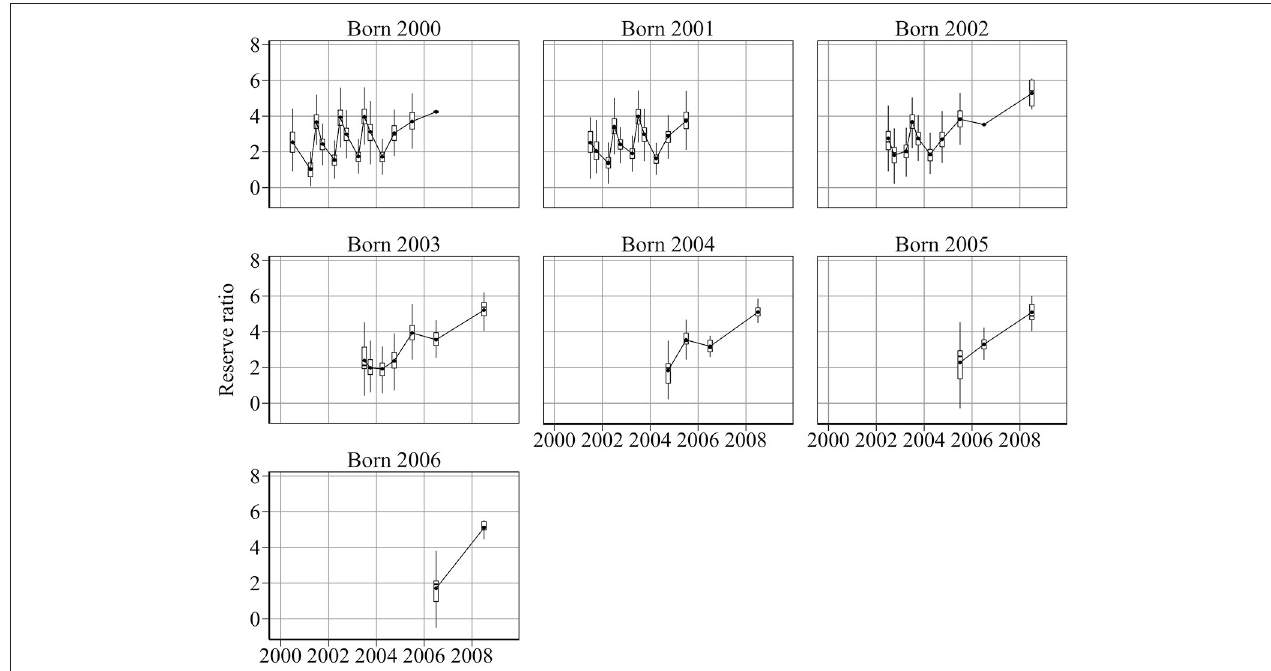
FIGURE 2 | Year-to-year changes in cohort reserve ratio, the proxy for sandeel condition. Sandeel condition is highly seasonal, reaching a minimum in March and a maximum in June. Condition generally increases with age.